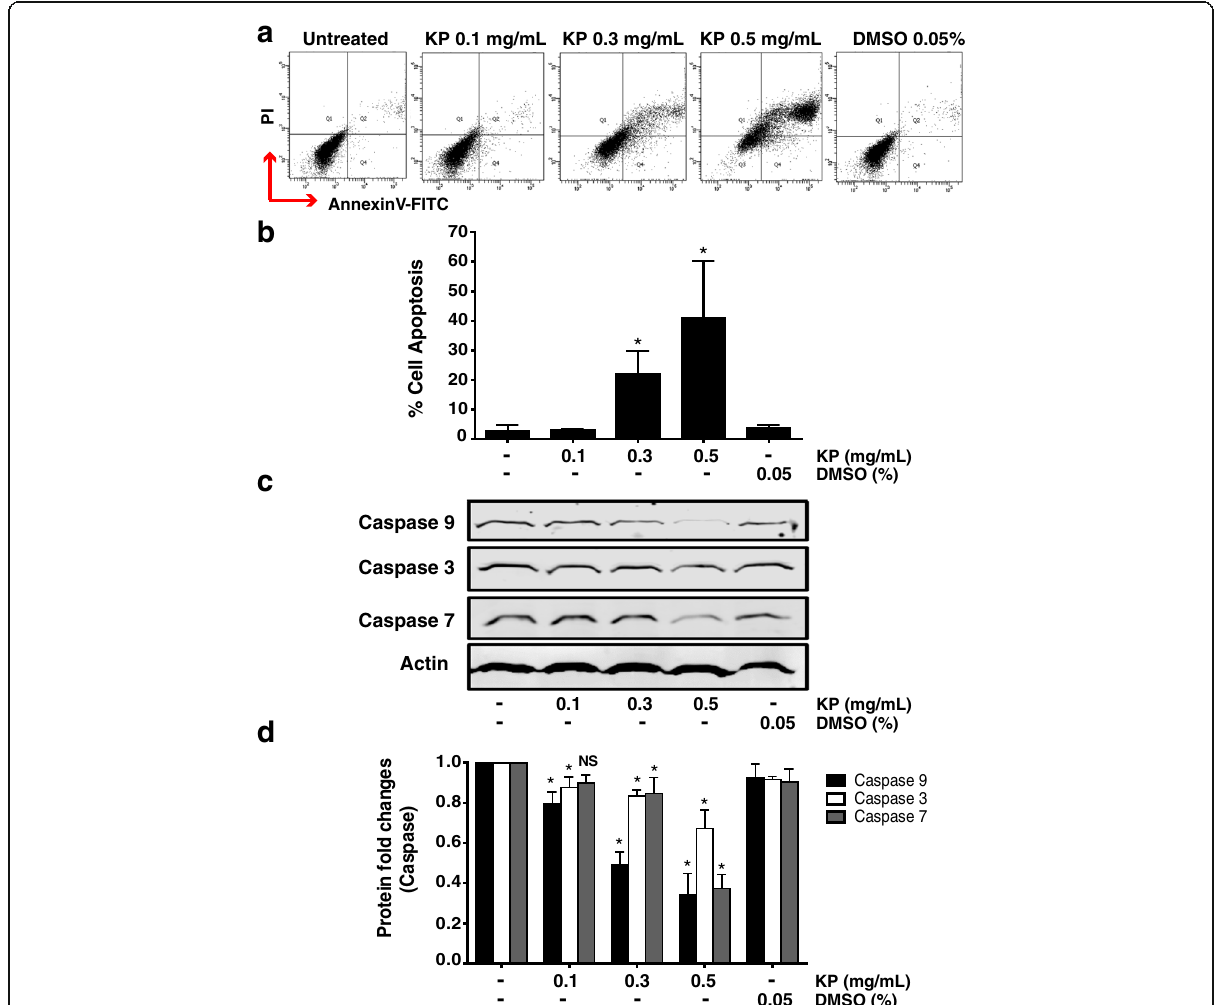
Fig. 7 The effect of KP ethanol extract on apoptosis and caspases in SKOV3 cells. Annexin V-FITC and PI labeling in KP treated cells was measured by flow cytometer ( a ) and histogram of percent of apoptotic cells is shown in b . The level of caspase-3, - 9, and -7 by western blotting are shown in c . Histogram of relative intensity of full-length of caspase-3, − -9, and -7. β -actin is used as a protein loading control ( d ). These data are represented as mean ± SD of three replicates. * P < 0.05 indicates significant difference compared to